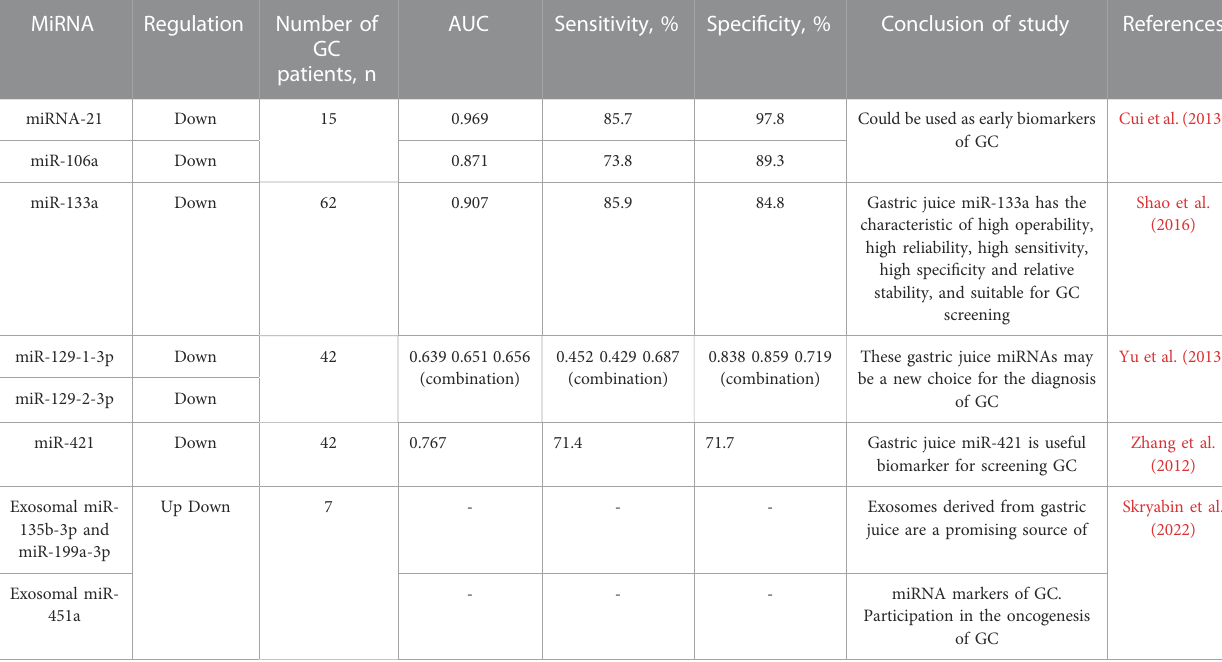
TABLE 2 Summarized several microRNAs (miRNAs) presenting modi fi ed circulating expression in gastric juice of gastric cancer (GC) patients compared to healthy controls or benign gastric diseases. MiRNA